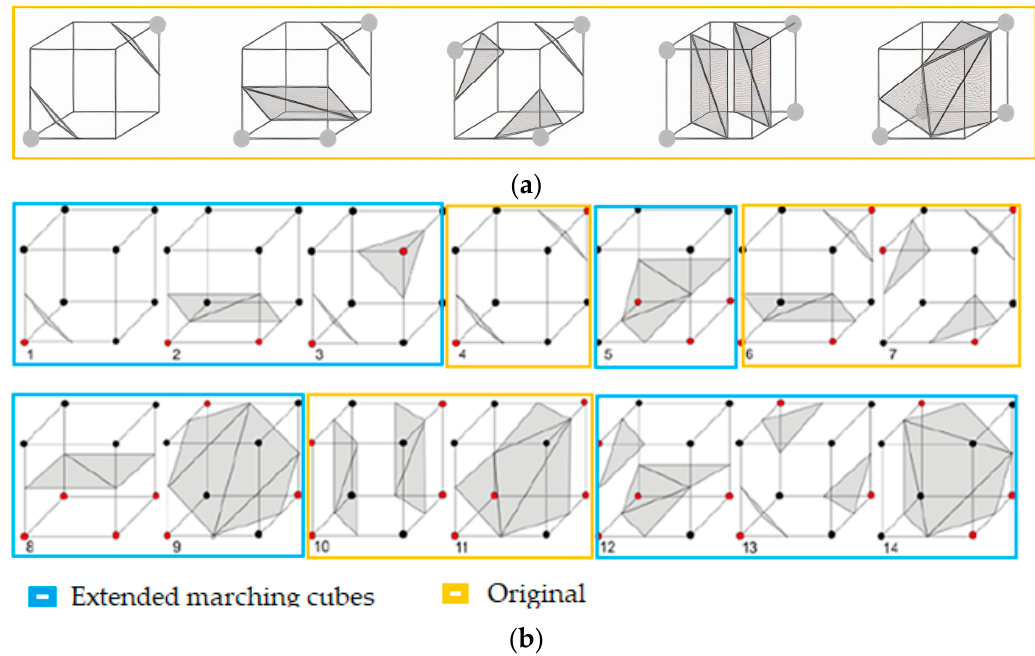
Figure 3. The modified Marching Cube triangulation cases lookup-table. ( a ) The original Marching Cube triangulation cases. ( b ) The modified Marching Cube triangulation cases.